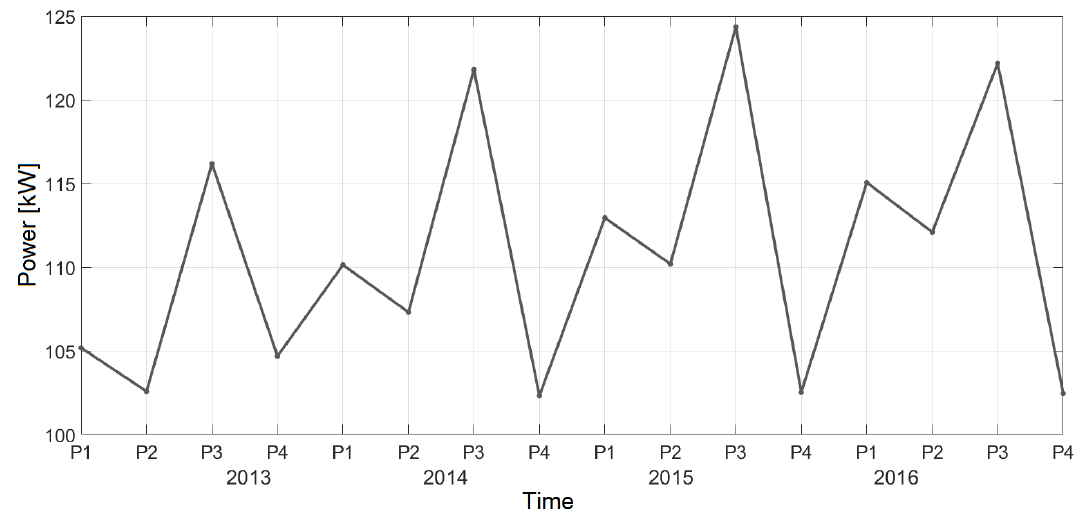
Figure 2. Quarterly average power: Universidad Politécnica Salesiana (P1: February–April, P2: May–July, P3: August–October, P4: